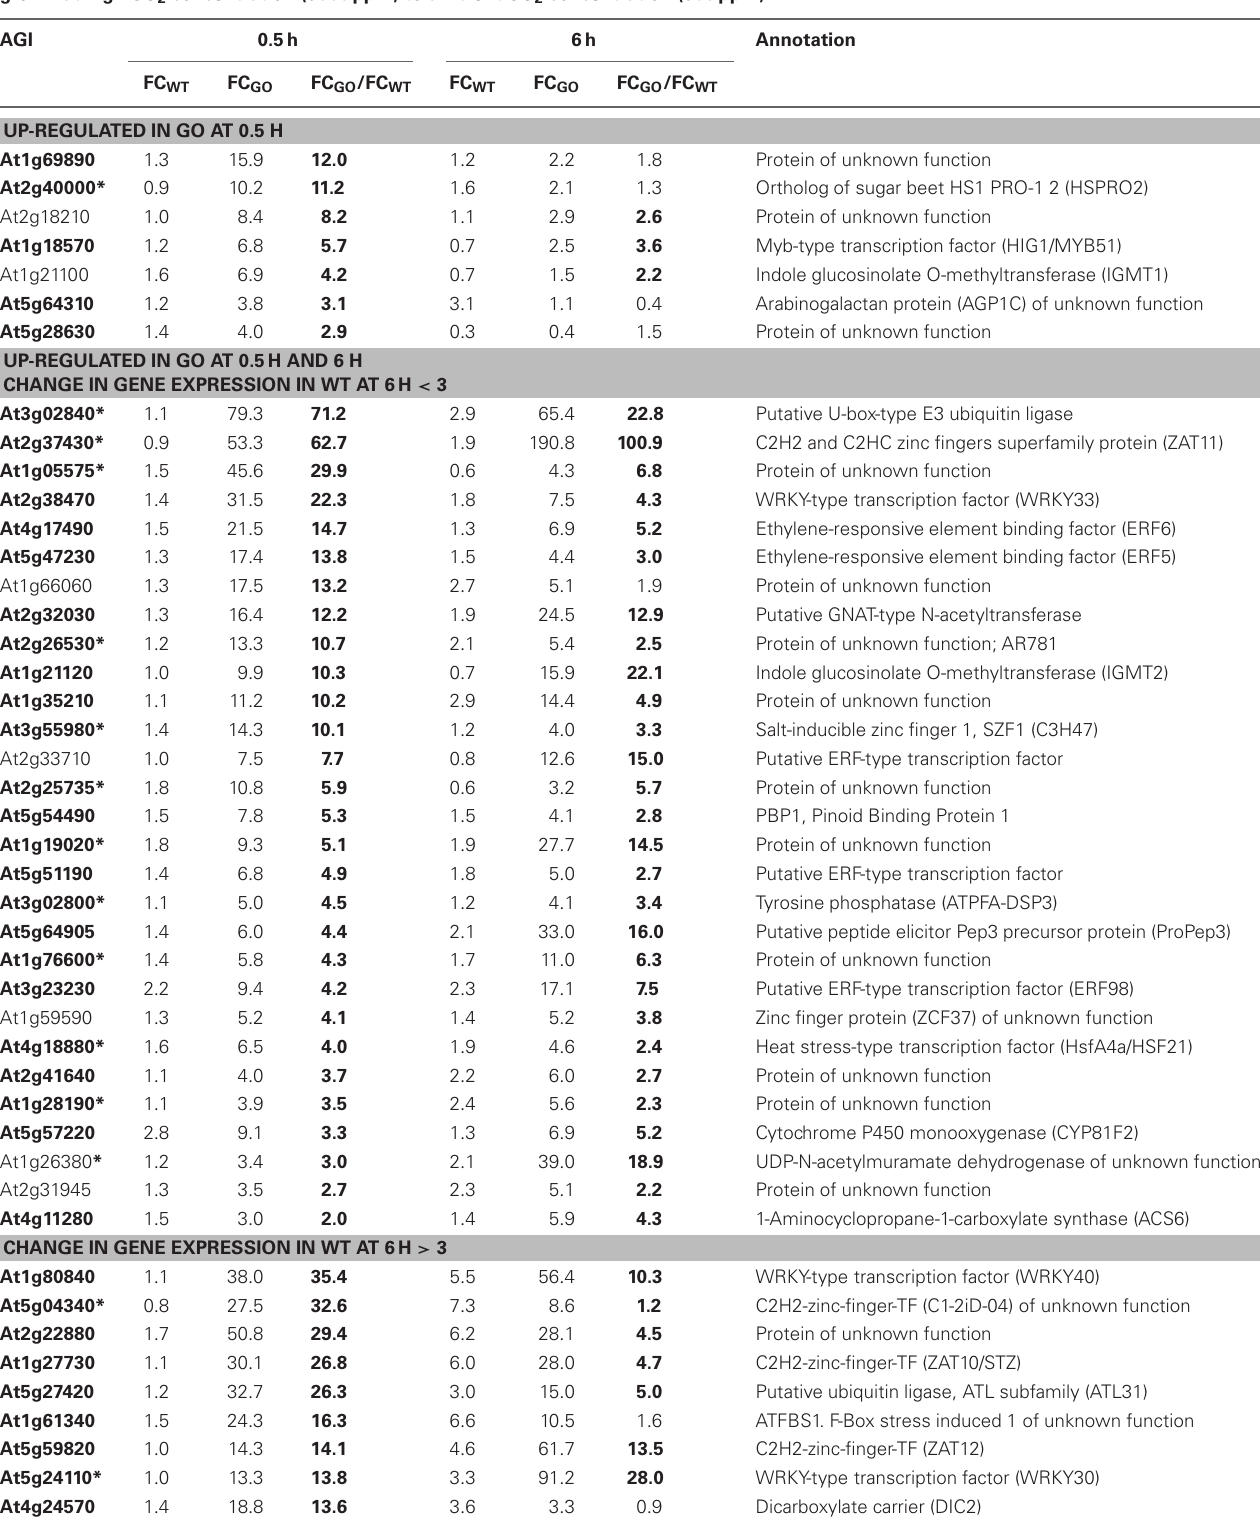
Table 2 | ROS-responsive genes (58 in total) the expression of which was enhanced by more than 3-fold in GO plants 0.5h after shifting plants grown at high CO 2 concentration (3000ppm) to ambient CO 2 concentration